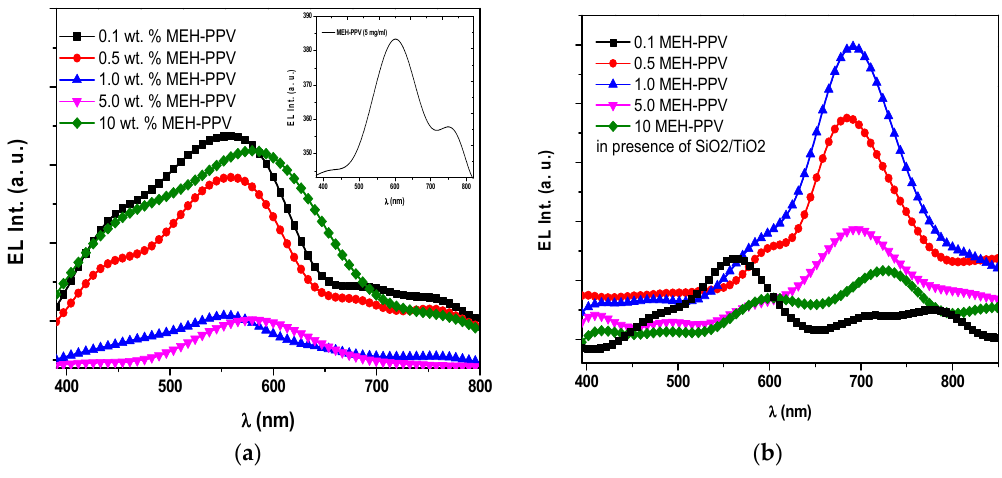
Figure 2. Electroluminescence (EL) spectra of the OLEDs based on PFO/MEH-PPV hybrids at applied voltages corresponding to maximum luminance. ( a ) In the absence of SiO 2 /TiO 2 nanocomposites; ( b ) in the presence of SiO 2 /TiO 2 nanocomposites. The inset shows the EL spectra of the OLEDs based on pristine MEH-PPV.